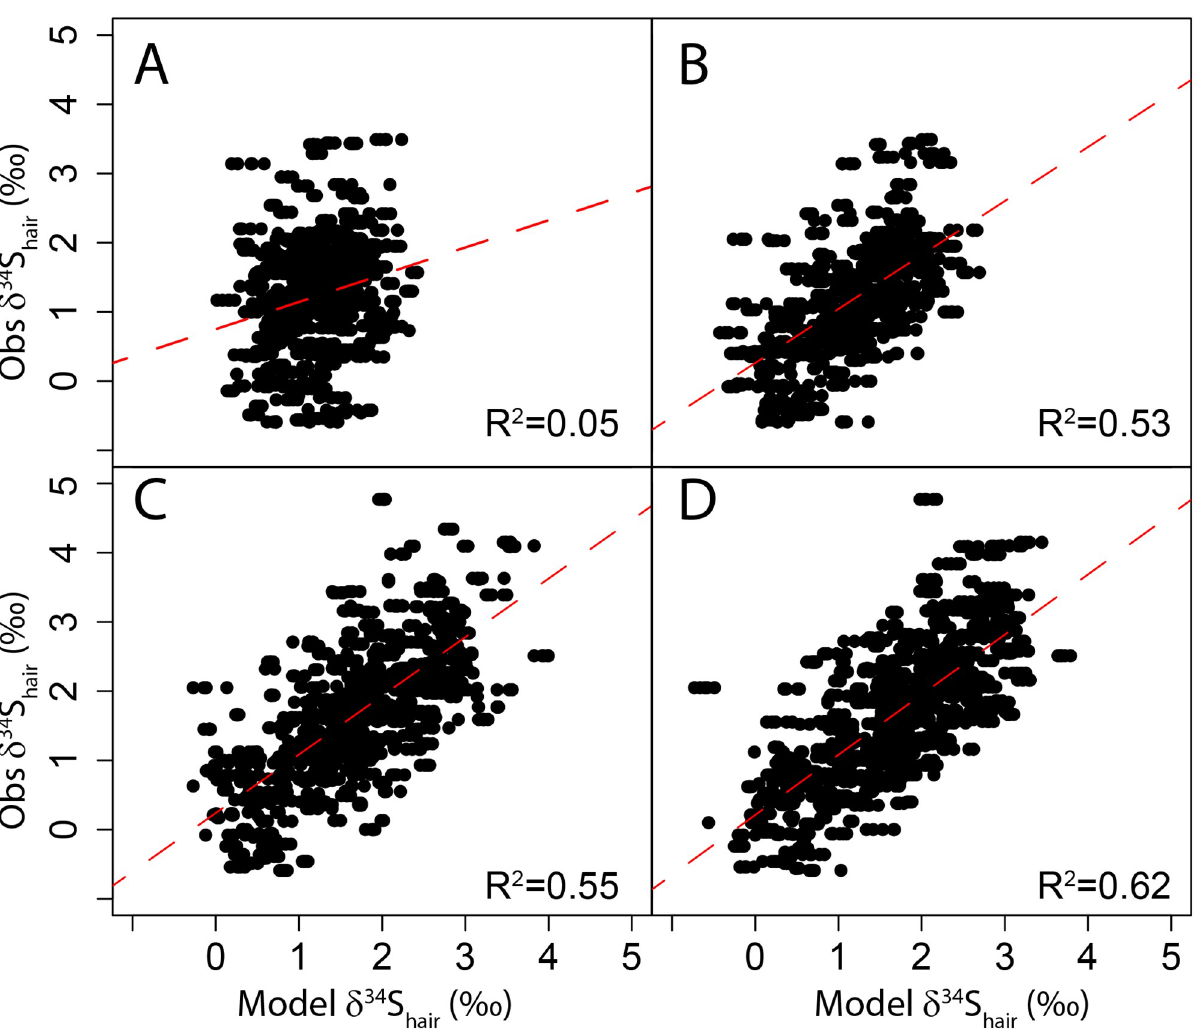
Fig 7. Observed δ 34 S hair against modeled δ 34 S hair . A. Dietary and demographic data regression model including seafood, wine, and water consumption; B. Dietary, demographic and geographic data regression model including longitude, seafood, wine, and water consumption; C. Environmental variables data regression model including sea salt aerosol deposition and soil pH; D. Dietary, demographic, geographic and environmental variable regression model including sea salt aerosol, soil pH, precipitation and seafood consumption. The red dashed line is the best fit linear